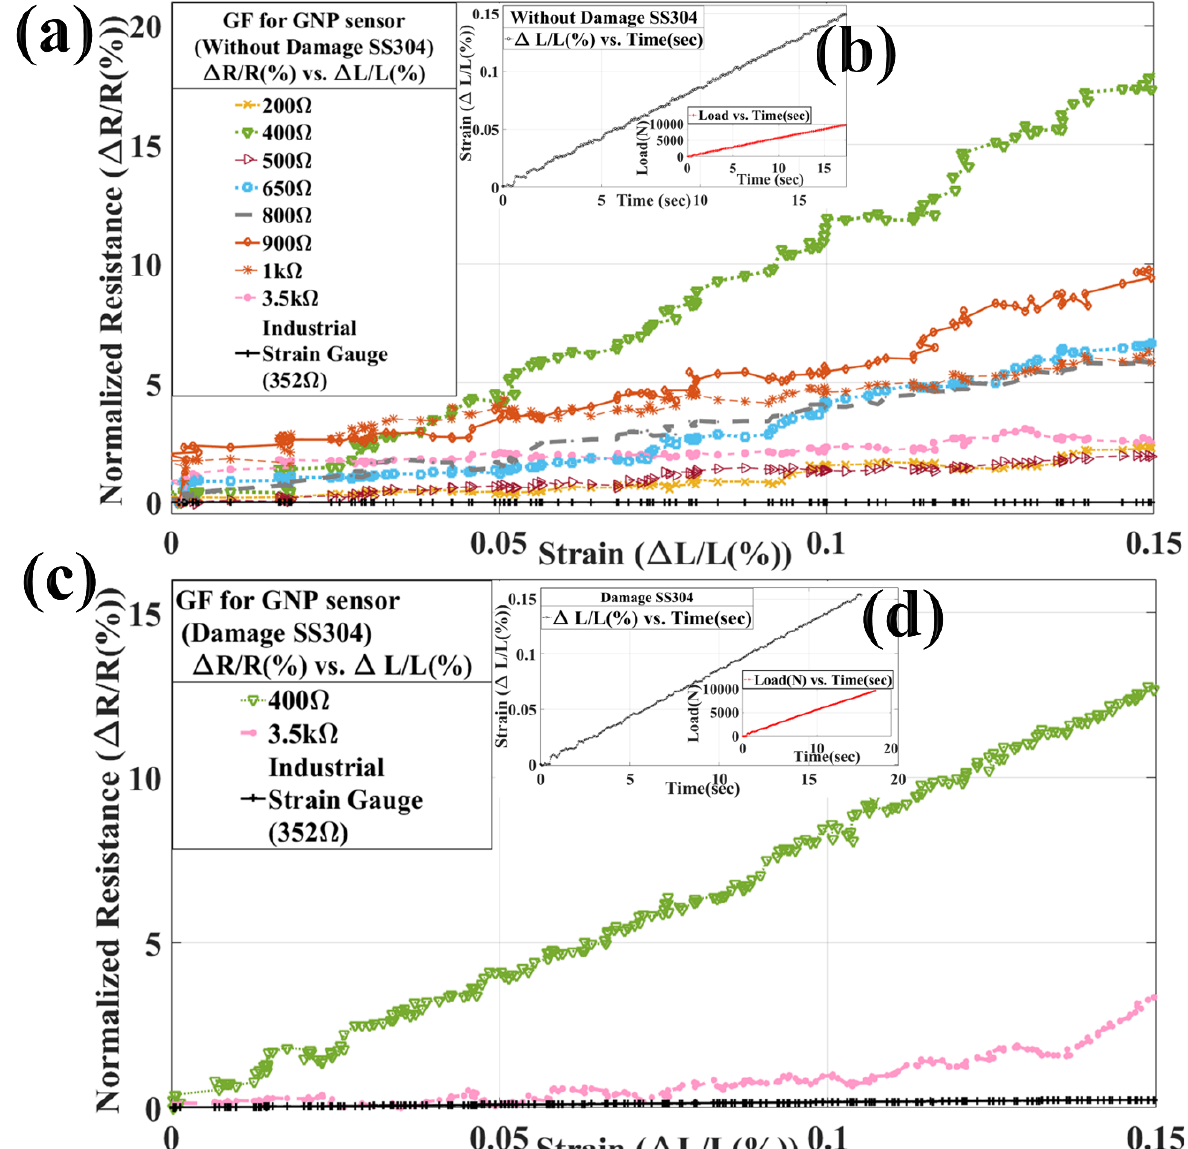
Figure 4. Graph showing gauge factor (GF) with defect and without-defect SS304 specimen: ( a , b ) GF calculation by GNPs/PMMA sensor without-defect specimen SS304 and corresponding strain data with respect to time, respectively; ( c , d ) GF calculation from highest and lowest GF GNPs/PMMA sensor with defect (hole) specimen SS304 and corresponding strain data with respect to time.